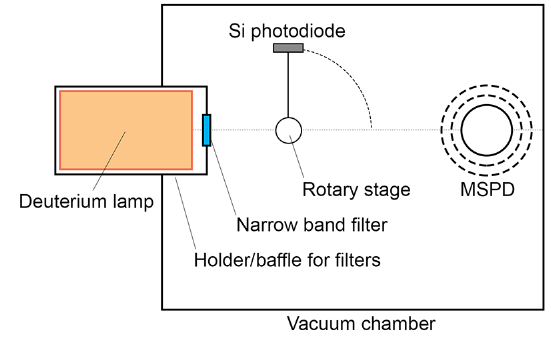
Figure 13. Layout of the experiment in the vacuum